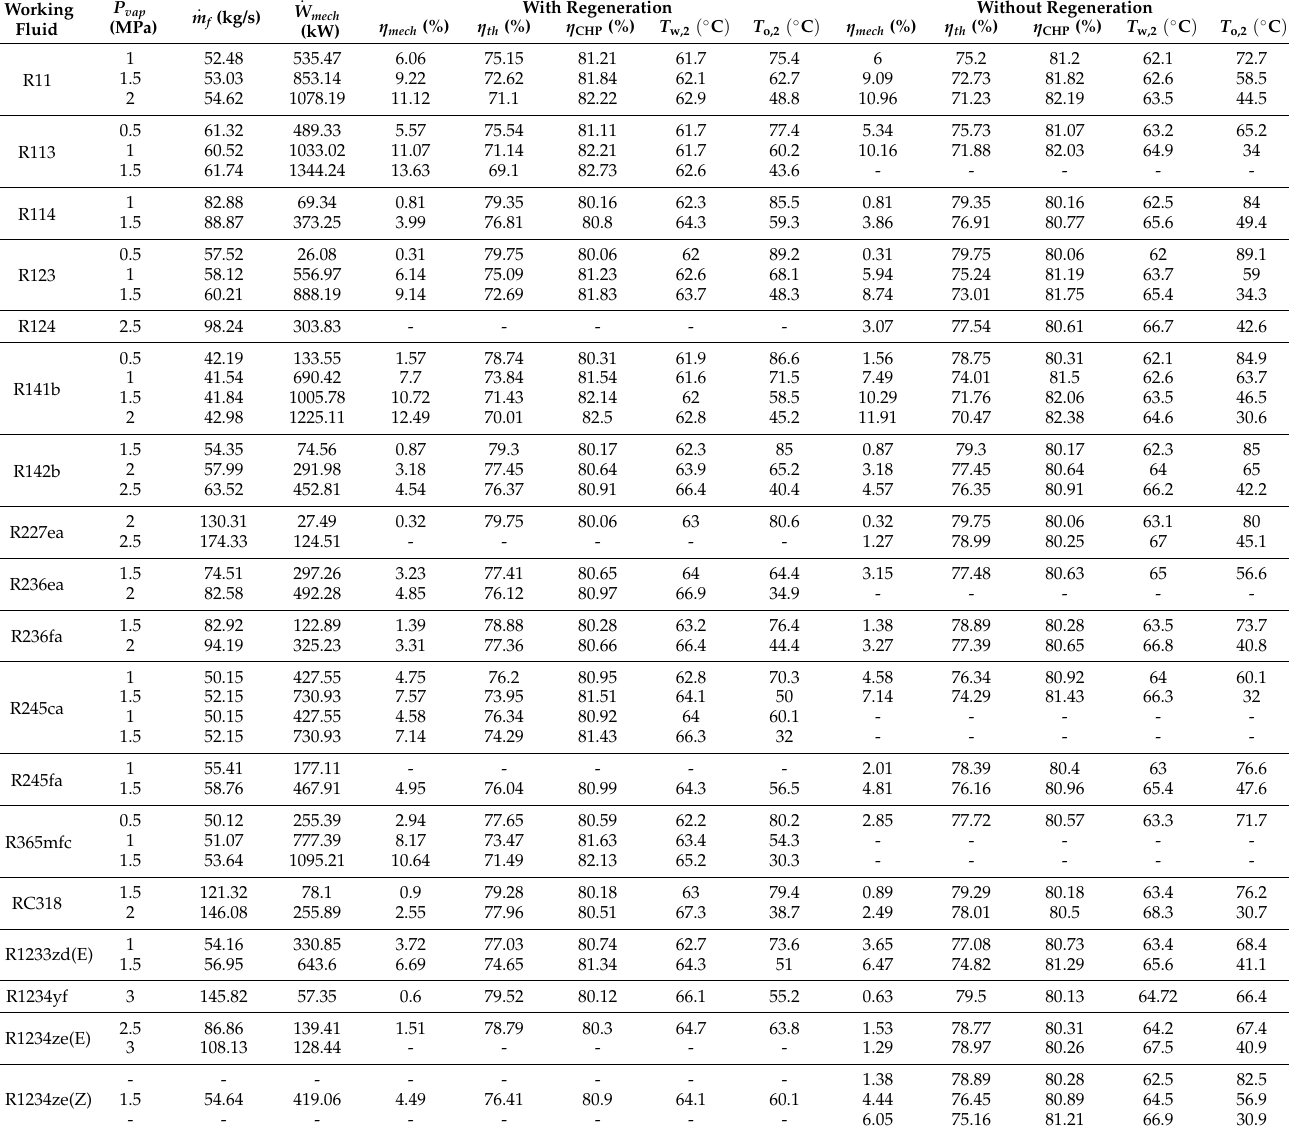
Table 4. Comparative presentation of the results for the refrigerants assumed in the present study.